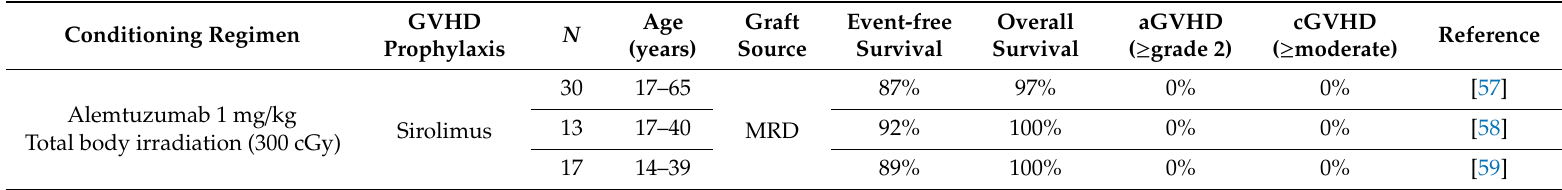
Table 3. Nonmyeloablative alemtuzumab / TBI conditioning regimens in adults with